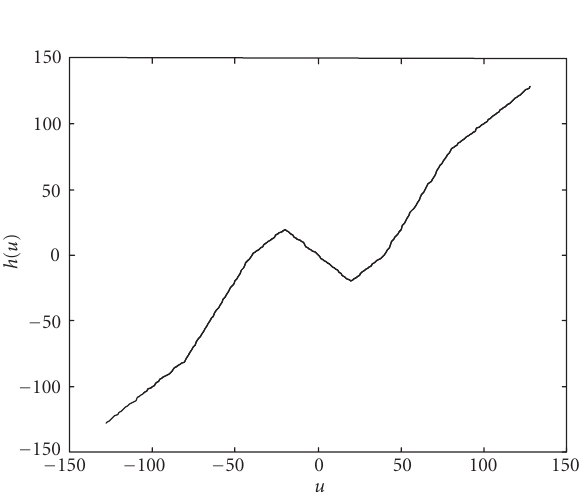
Figure 2: Example of graphical representation of function h ( u